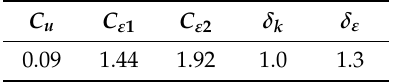
Table 1. Standard k – ε model